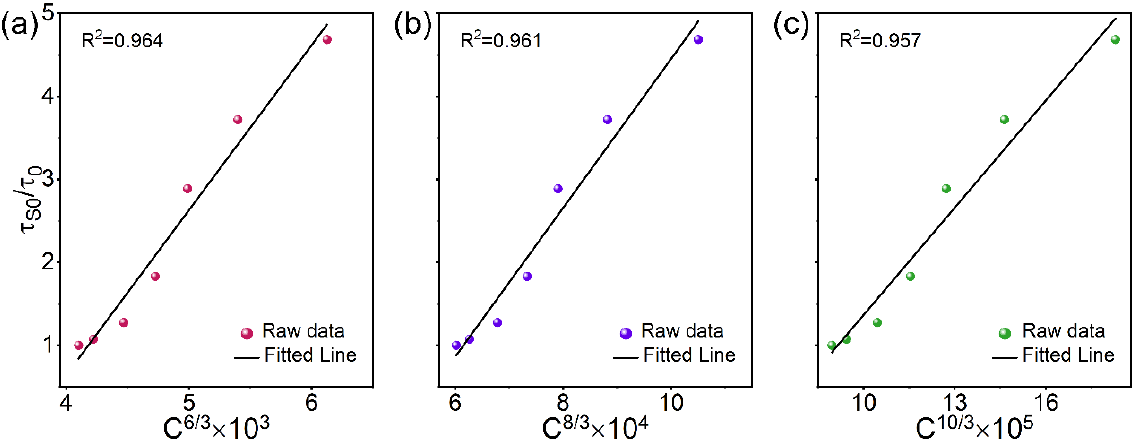
Figure 7. Relationship between τ S0 /τ 0 and ( a ) C 6/3 , ( b ) C 8/3 , and ( c ) C 10/3 .